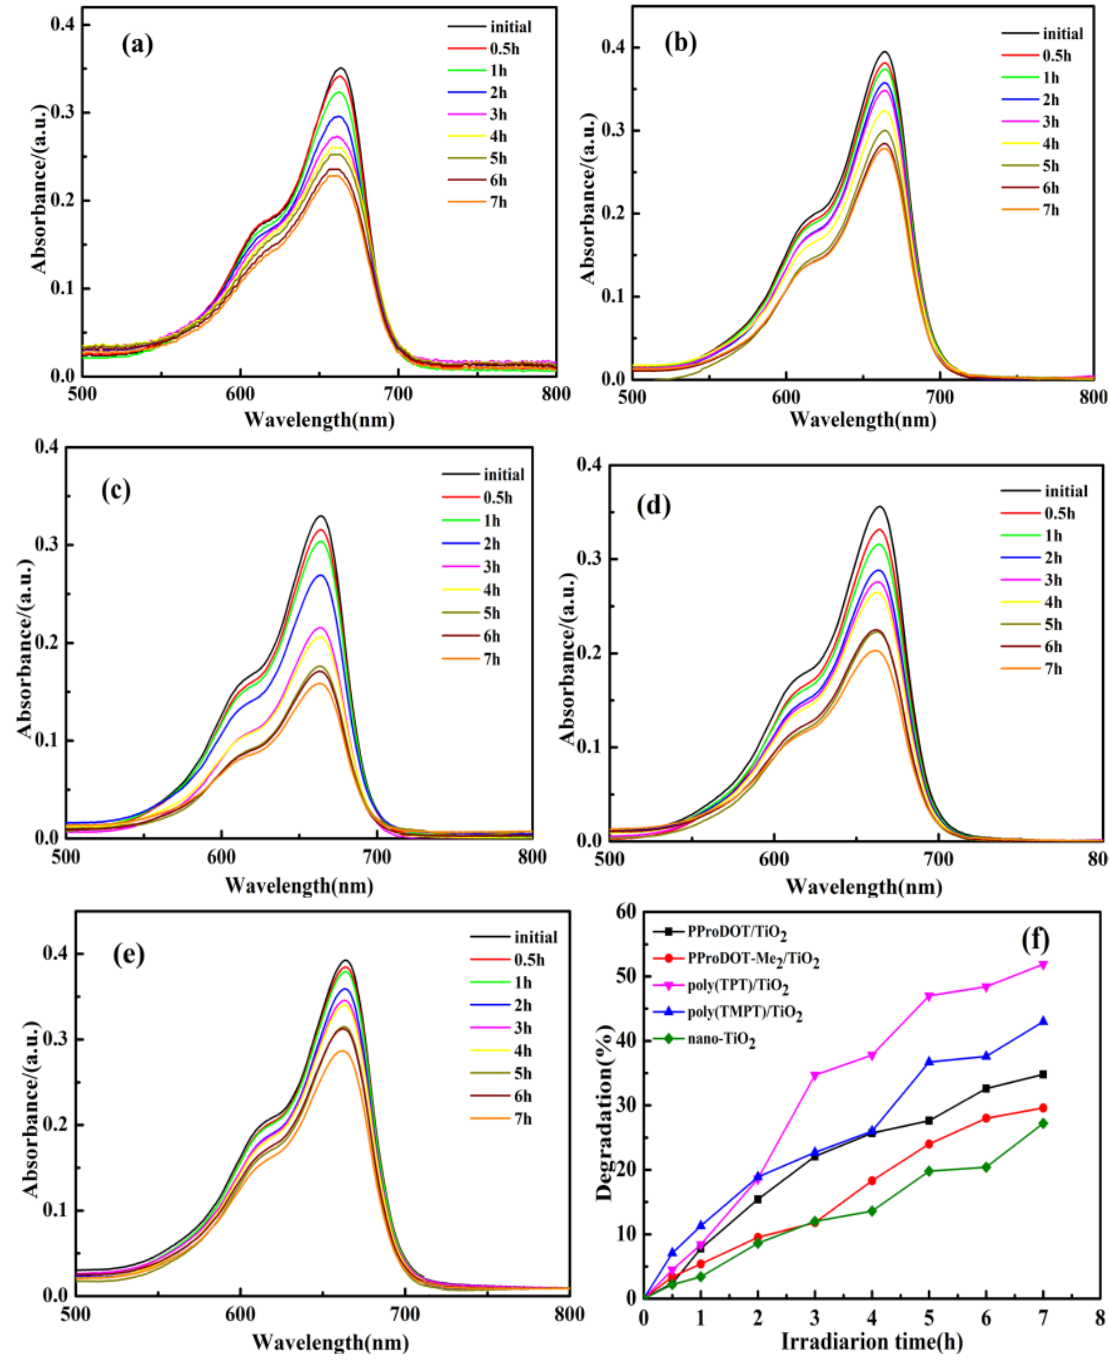
Figure 6. The UV-Vis absorption spectra of methylene blue (MB) dyes by photocatalysis for different irradiation times under UV light irradiation: ( a ) PProDOT/TiO ( b ) PProDOT-Me /TiO ; ( c ) poly(TPT)/TiO ; ( d ) poly(TMPT)/TiO 2 2 2 and ( f ) the degradation efficiency of the MB dyes (catalyst concentration: 0.4 mg/mL; initial concentration of dyes: 1 × 10 − 5